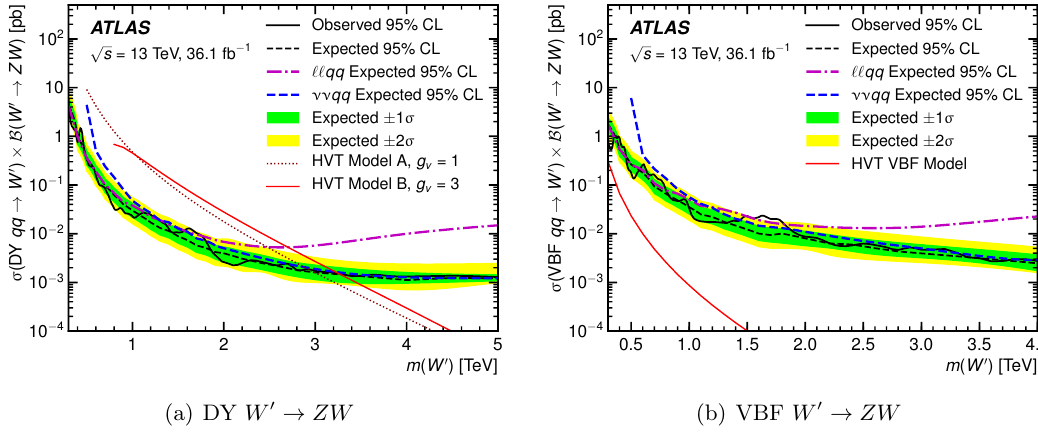
Figure 13 . Observed (black solid curve) and expected (black dashed curve) 95% CL upper limits on (cid:27) ( W 0 ZW ) at p s = 13 TeV for the (a) DY and (b) VBF production of a W 0 boson in (cid:2) B ! the HVT model as a function of its mass, combining ‘‘qq and (cid:23)(cid:23)qq searches. Limits expected from individual searches (dashed curves in blue and magenta) are also shown for comparison. Limits are calculated in the asymptotic approximation below 2 TeV and are obtained from pseudo-experiments above that. Theoretical predictions are overlaid in (a) for HVT Model A and Model B and in (b) for HVT VBF Model . The green (inner) and yellow (outer) bands represent the uncertainty in the expected